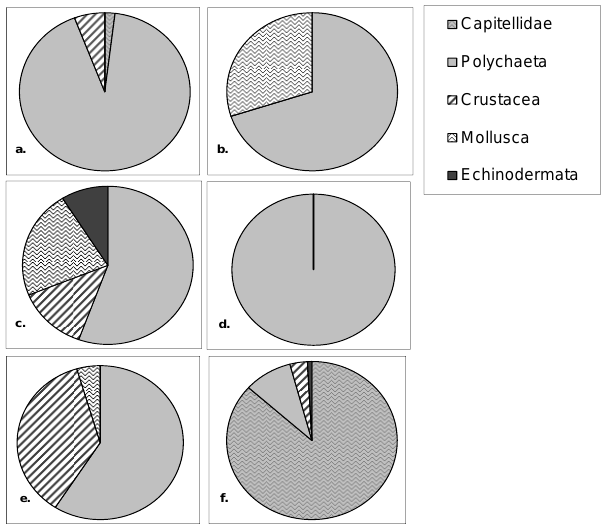
Fig. 5. Composition of higher macrofaunal taxa in ambient and col- onization trays on the W. Indian margin. (a) Ambient fauna at 800 to 835m on transect 1; (b) colonizers at 802m on transect 1; (c) am- bient fauna at 800 to 814m on transect 2; (d) colonizers at 817m on transect 2; (e) ambient fauna at 1148m on transect 2; and (f) colonizers at 1147m on transect 2.